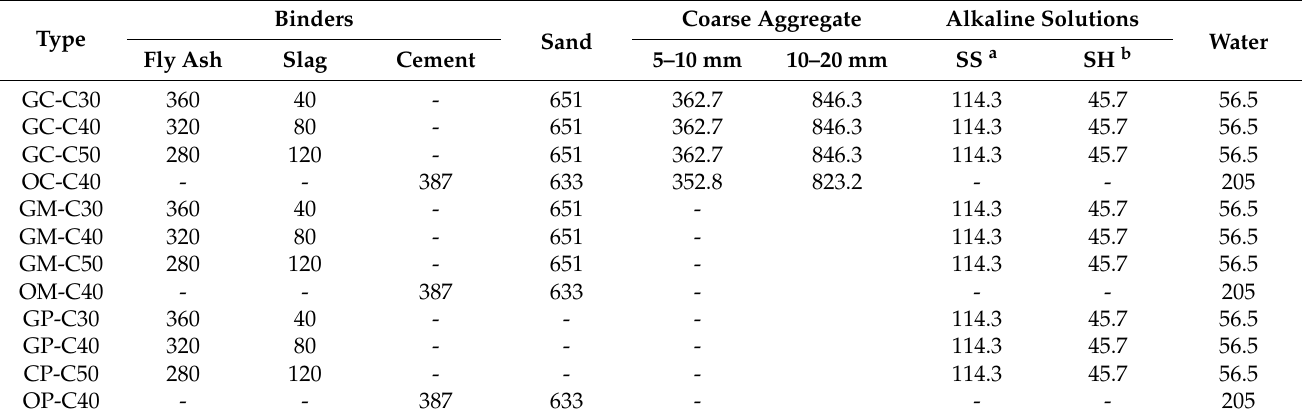
Table 2. Details of concrete, mortar and paste mix proportions (mass per unit volume, kg).